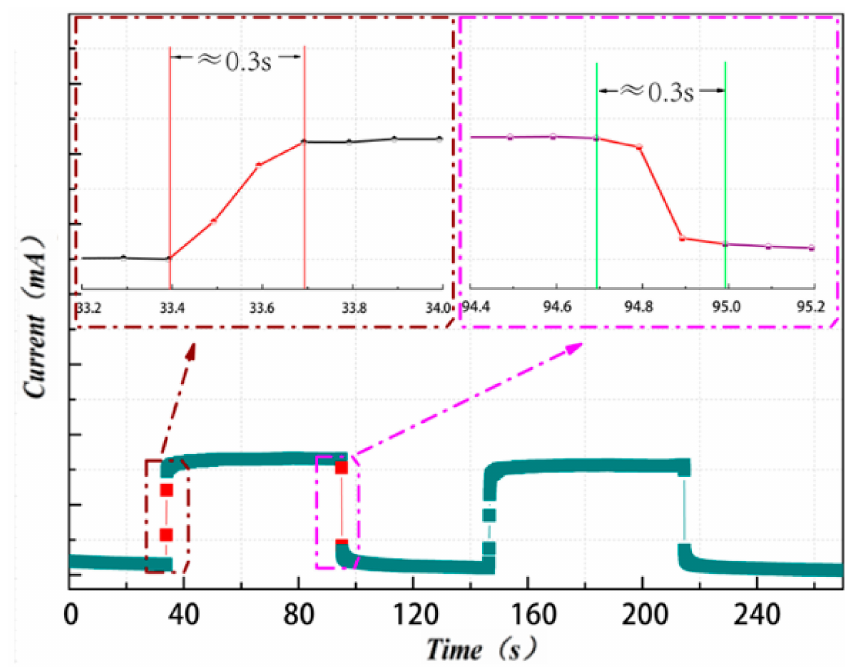
Figure 8. The response time and the recovery time of the reduced graphene oxide / polyurethane (rGO / PU) composite foam sensor.